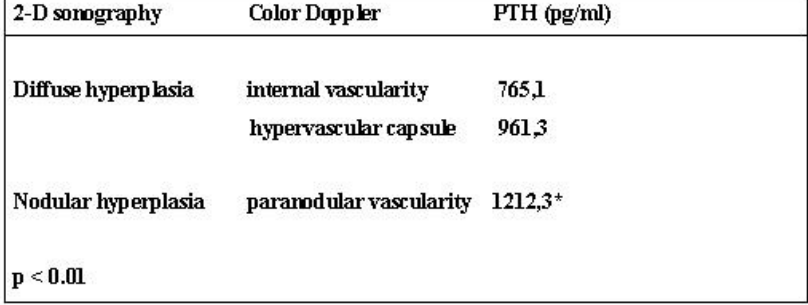
PTH Level Depending on Ultrasonographic